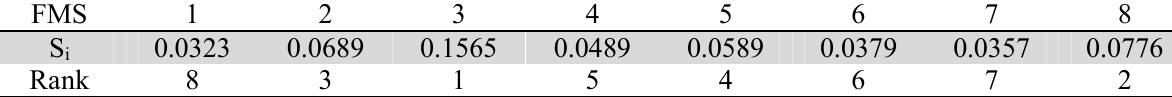
Appraisal score and rank of each alternative FMS in EVAMIX method